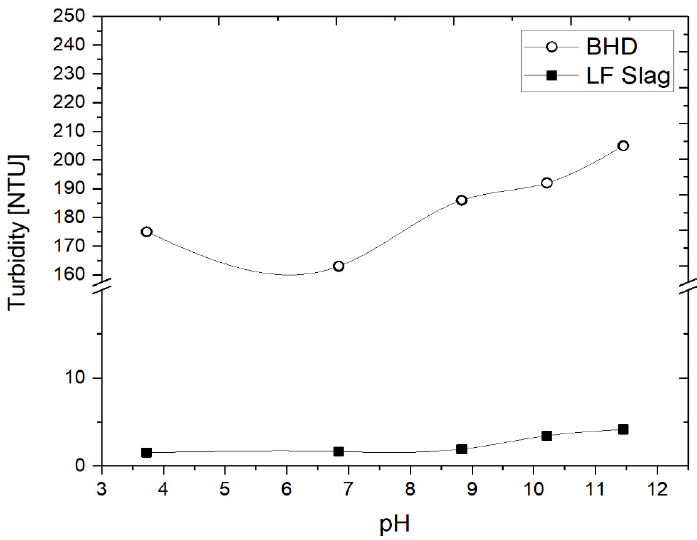
Figure 3. Turbidity of steel dust LF and BHD in distilled water.